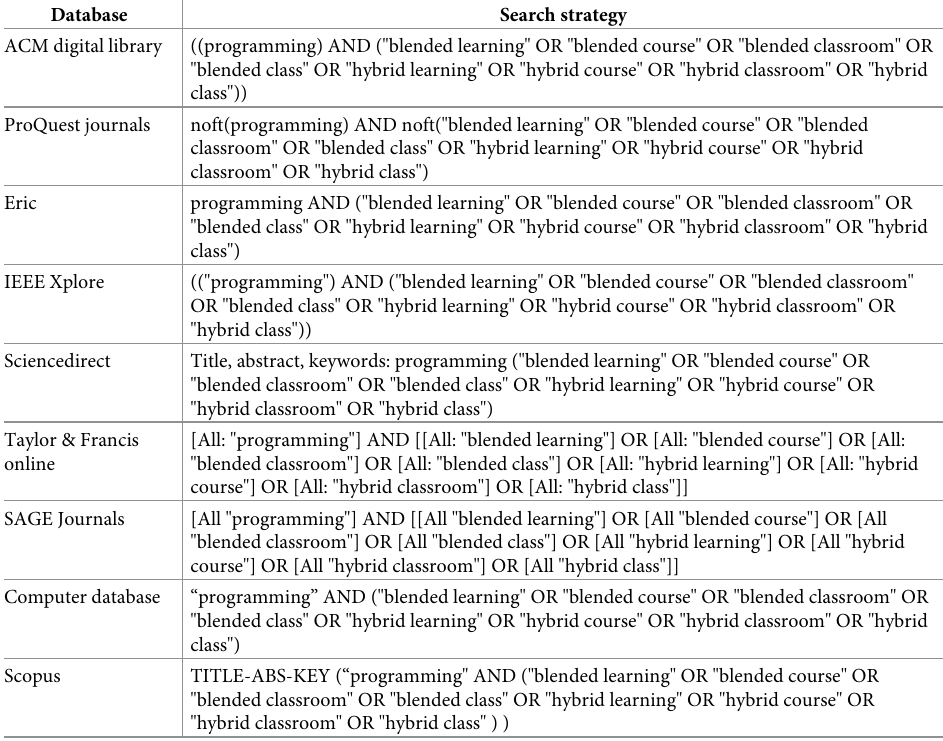
Table 1. Search strategies for